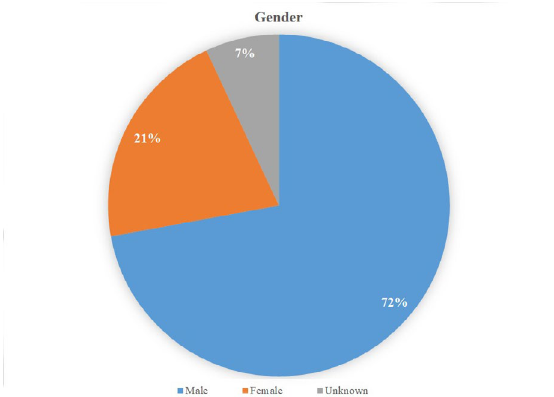
Figure 1. The gender distribution of patients with aortic thrombosis in COVID-19